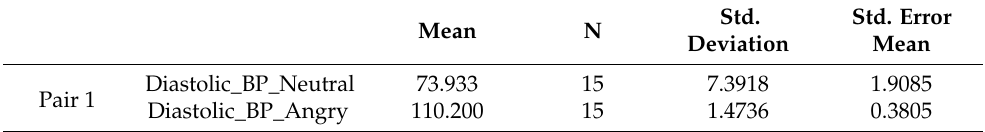
Table 9. Paired samples statistics for diastolic BP (neutral to angry state).